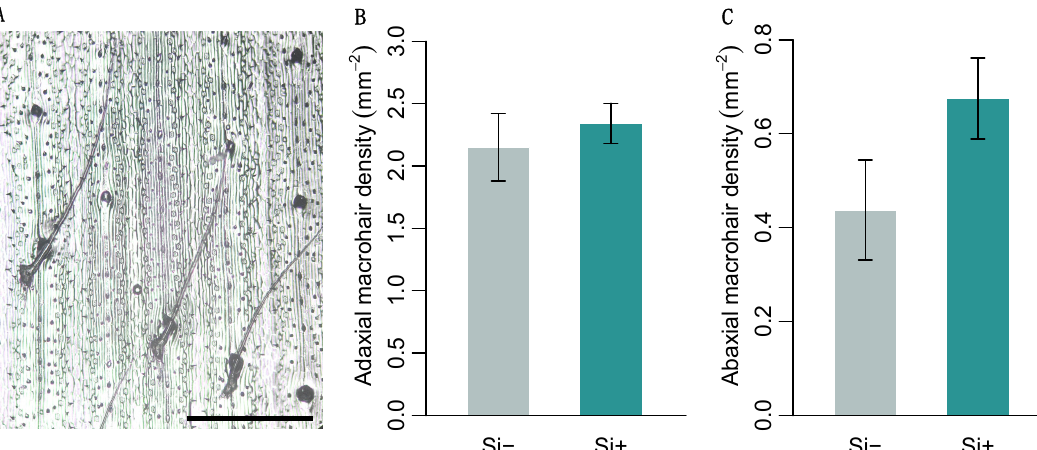
Figure 2. Brachypodium distachyon macrohair density in response to Si supplementation. ( A ) Image of macrohairs from epidermal leaf peels, scale bar: 0.5 mm. Macrohair density was quantified on ( B ) the adaxial ( n = 12) and ( C ) abaxial leaf surfaces ( n = 8–12). Values are means ± SE.